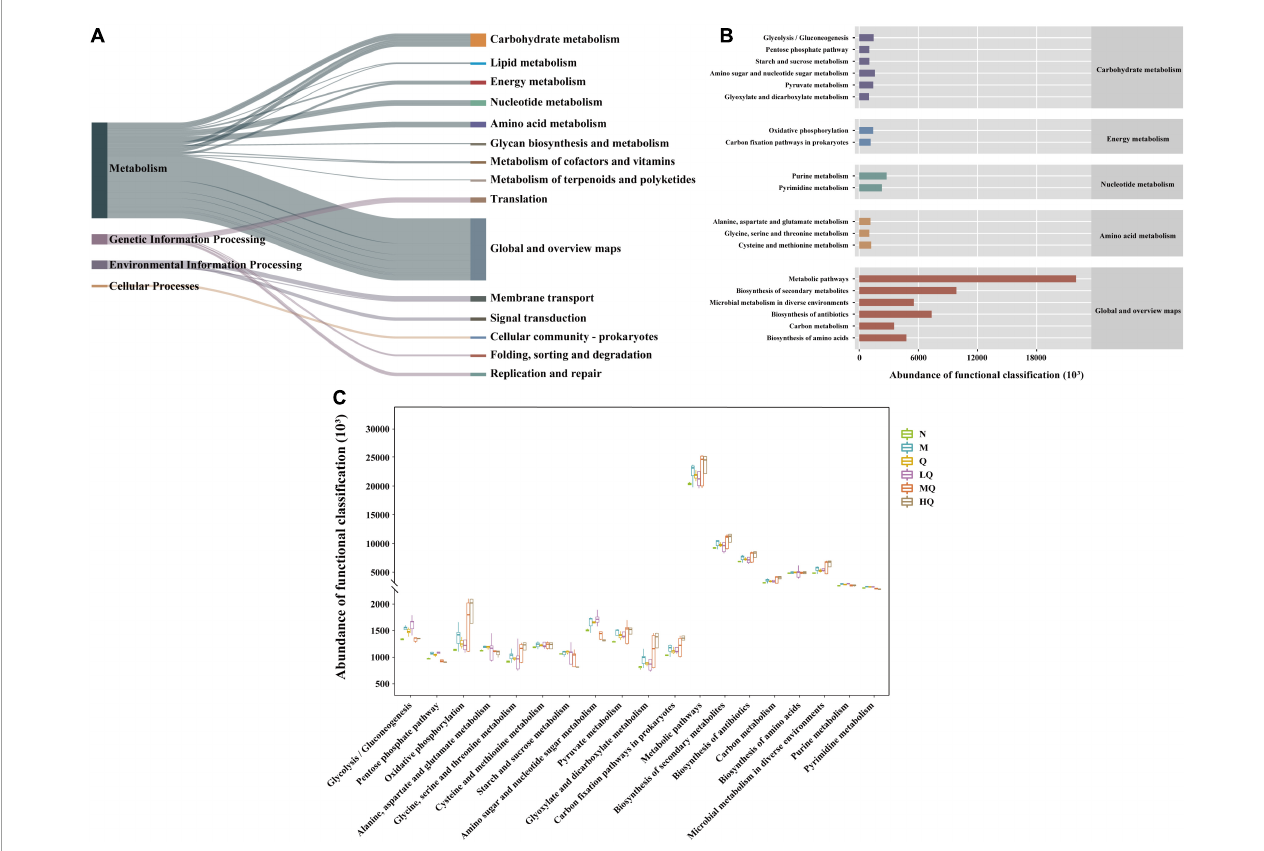
FIGURE7 PICRUst-based examination of intestinal mucosal microbiota; (A) Kyoto Encyclopedia of Genes and Genomes (KEGG) functional categories (levels 1 and 2). (B) Metabolic histogram (levels 2 and 3). (C) Comparisons between the groups for each KEGG functional categories (level 3).